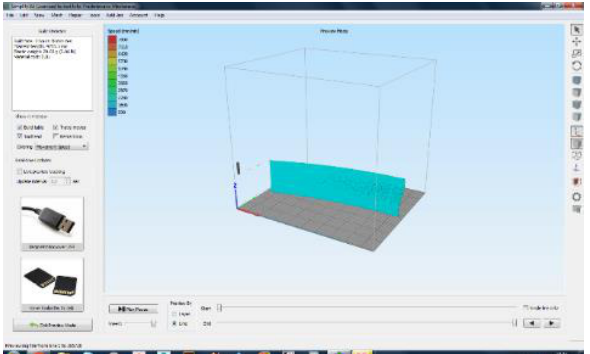
Figure 9: Verification of the fitting of the Rhinoceros © model on the Felix 3.1 © Simplify 3d © software. This verification